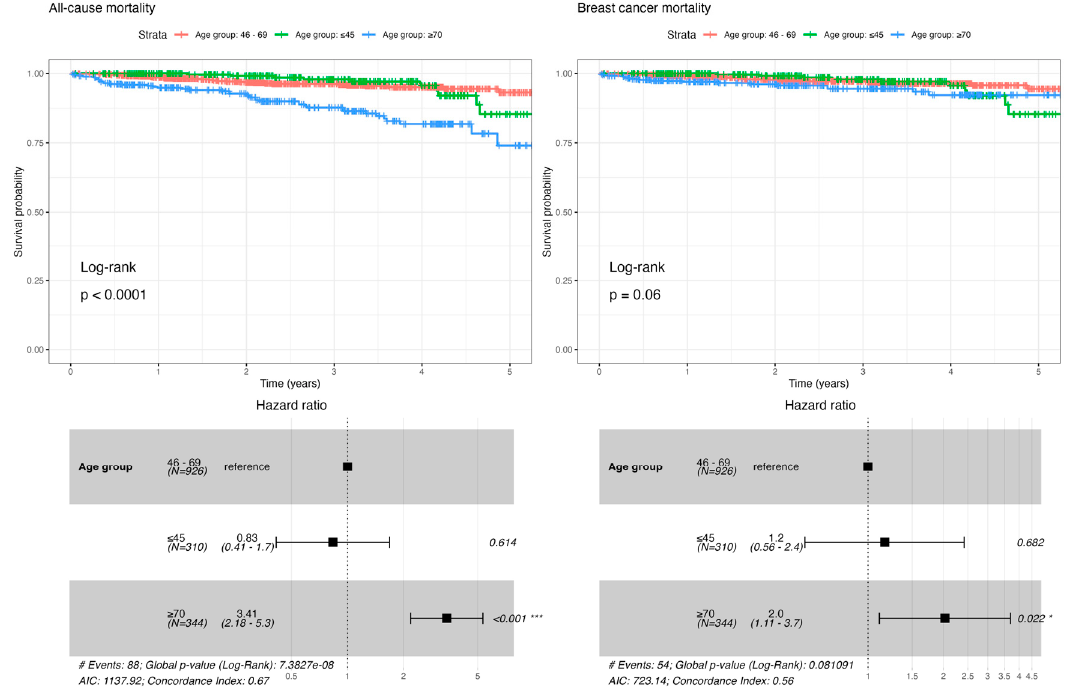
Figure 1. All-cause mortality and BC-specific mortality by age group (* p < 0.05, *** p < 0.001) .